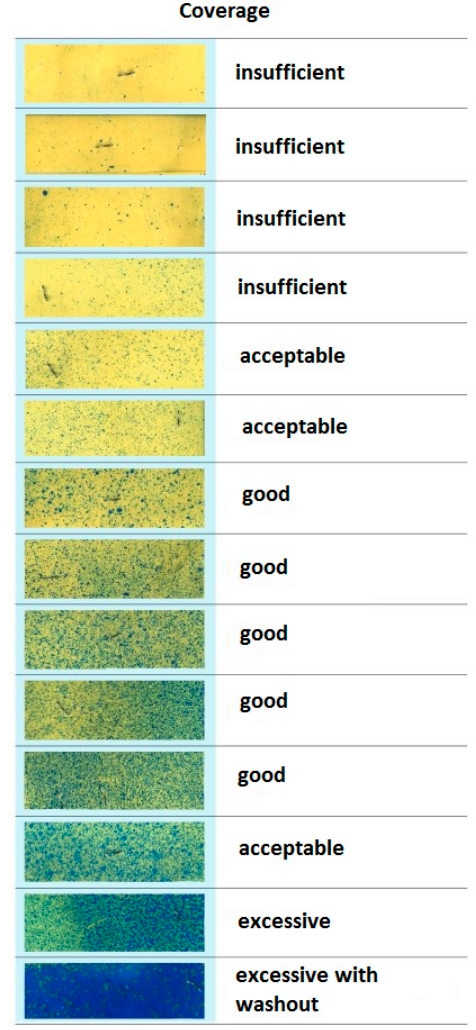
Figure 4. Degree of coverage of water sensitive papers [19].